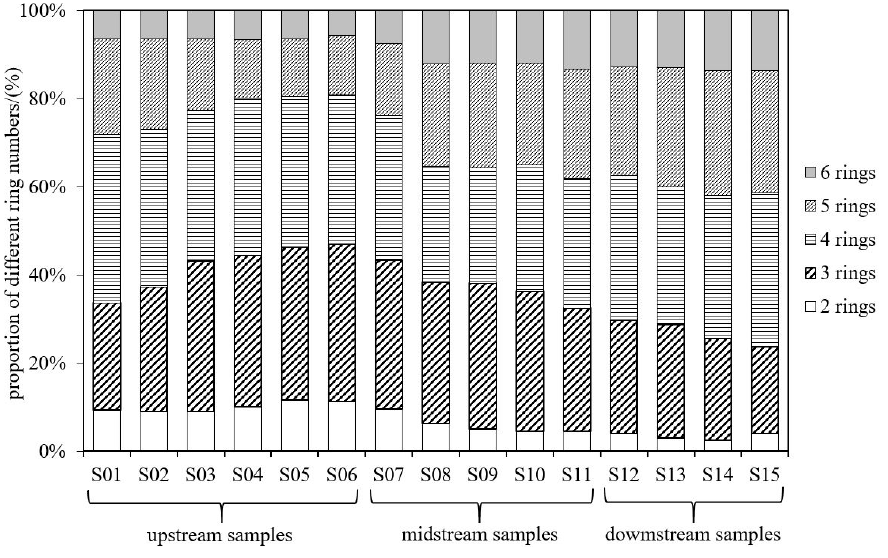
Figure 3. Composition distribution of PAHs in groundwater